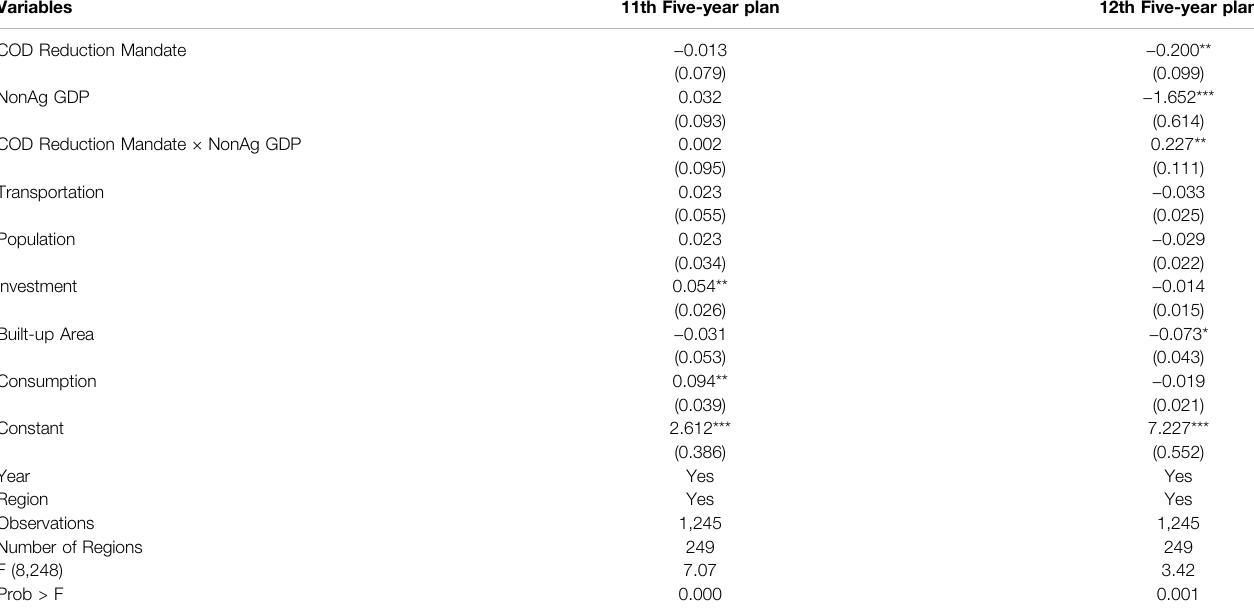
TABLE 2 | Fixed effect model.